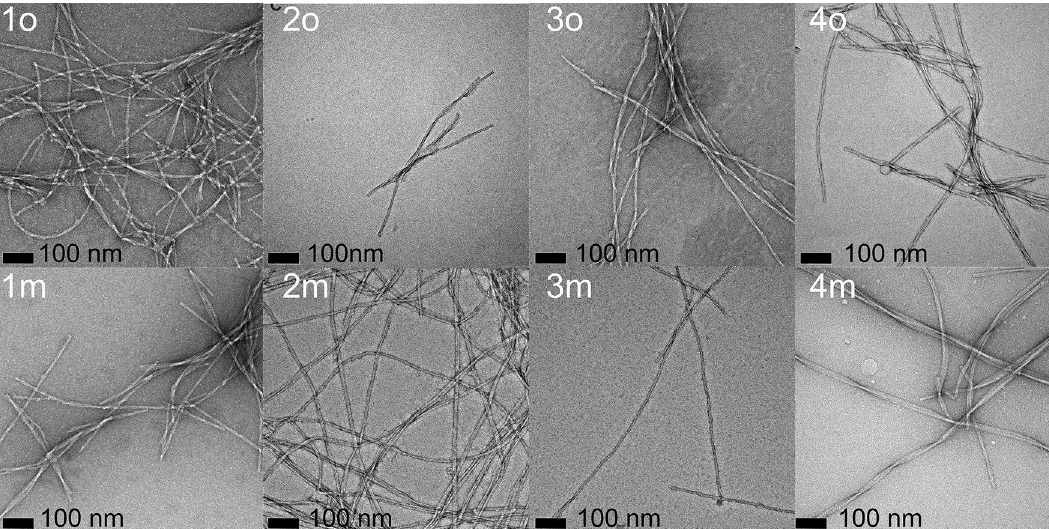
Figure 2. Transmission electron microscopy images of brain parenchyma- and vascular-seeded Aβ40 fibrils. o = brain parenchyma (occipital) -seeded; m = vascular-seeded. Numbers are patient numbers (same as for Fig. 1). In all cases, magnification was 49,000 × magnification (with additional 1.4 × magnification from CCD camera). Scale bar indicates 100